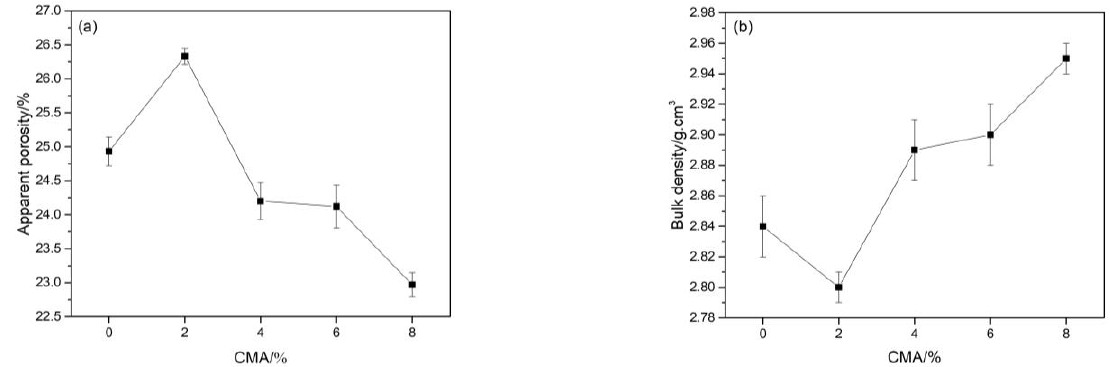
Figure 7. Apparent porosity ( a ) and bulk density ( b ) of samples after sintering at 1600 °C for 3 h.